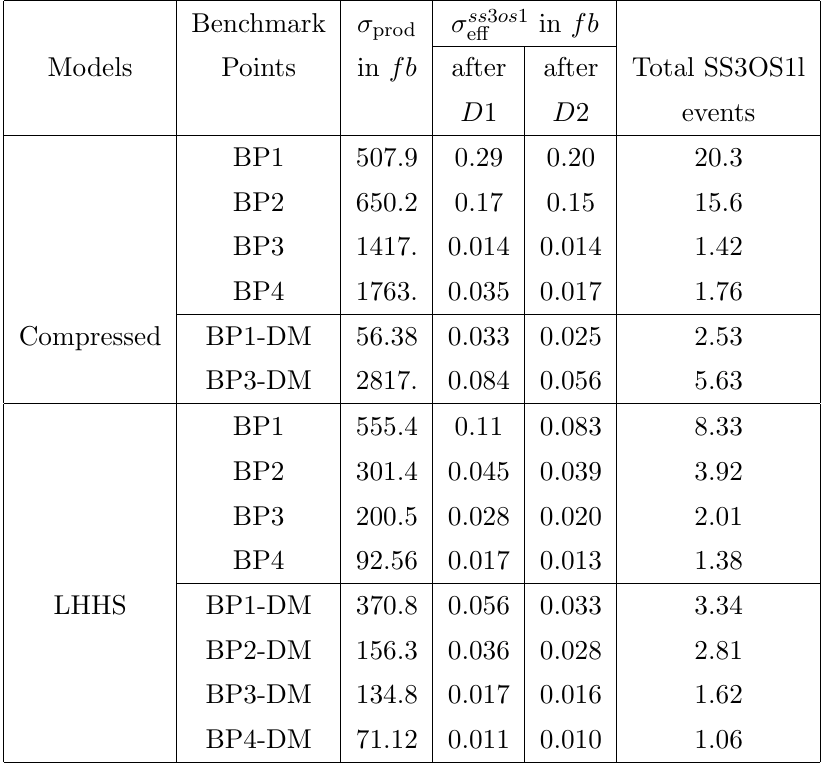
after successive cuts e(cid:11)